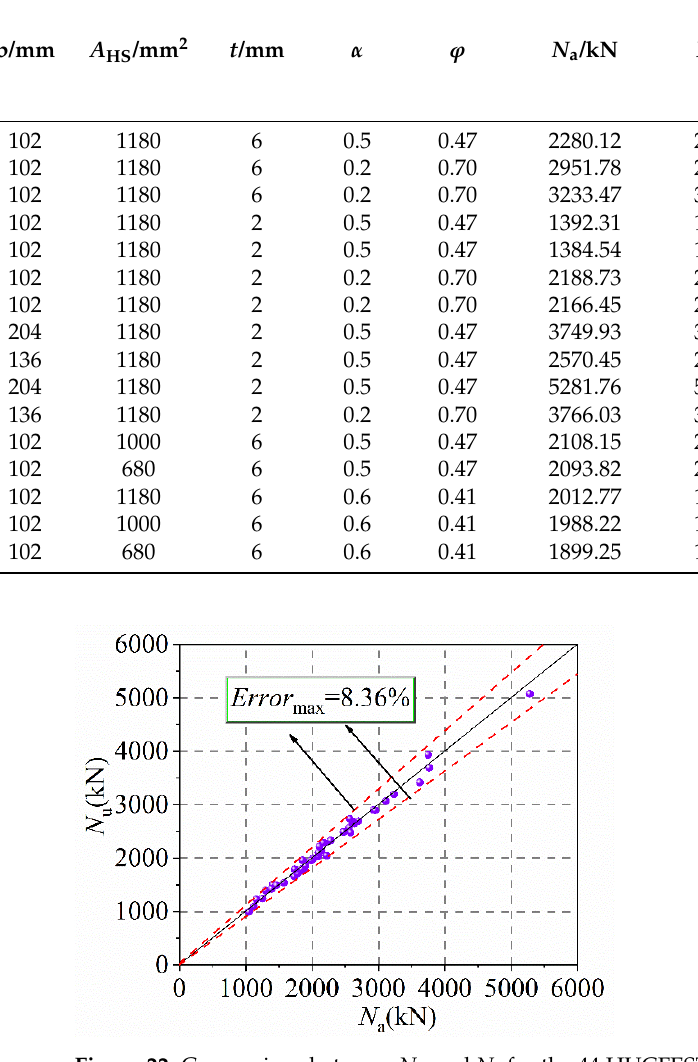
Figure 22. Comparison between N a and N t for the 44 HUCFESTCs.